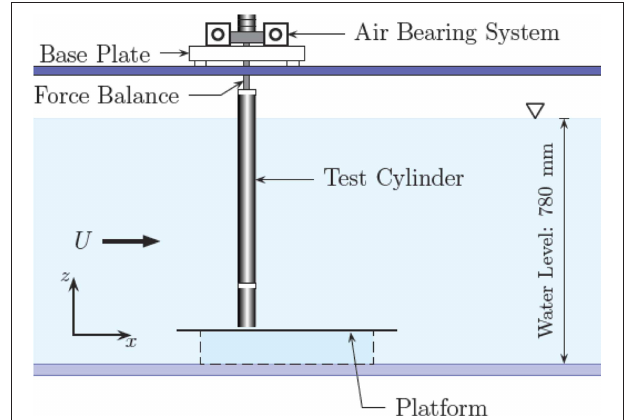
FIGURE 1 | Schematic of the experimental